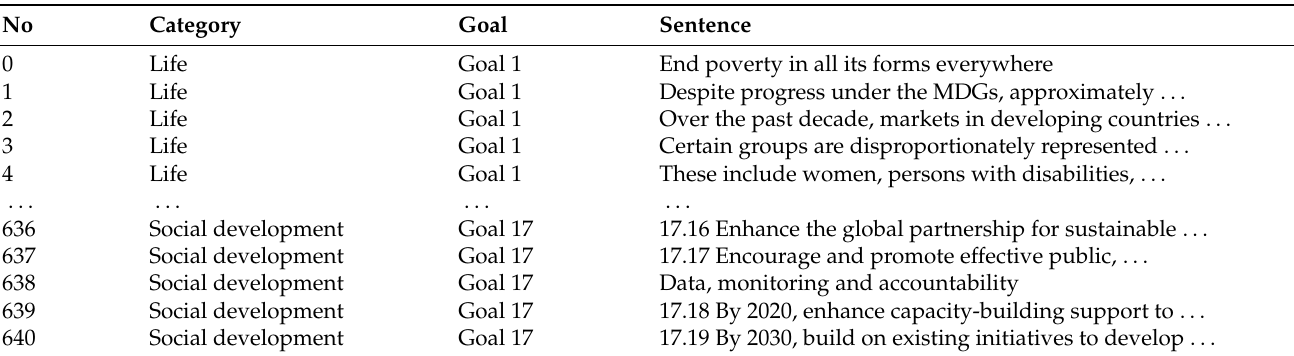
Table 4. Sentences obtained from the 17